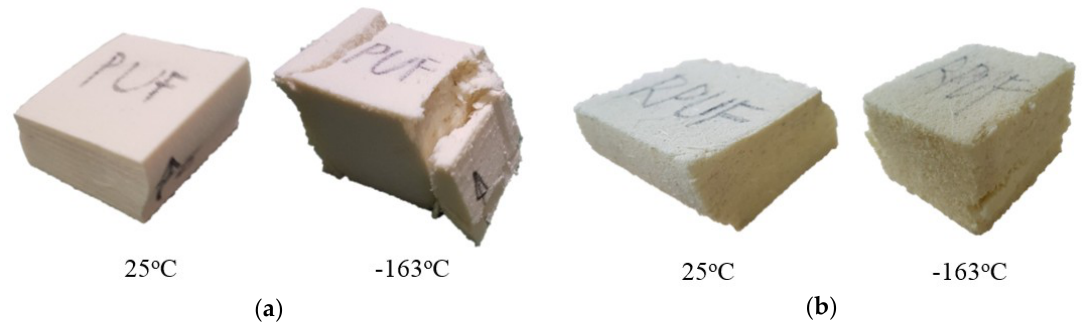
Figure 5. Shape of the specimens after the compressive test according to the temperature under the standard of the conventional compressive test: ( a ) PUF, ( b ) reinforced polyurethane foam (RPUF).